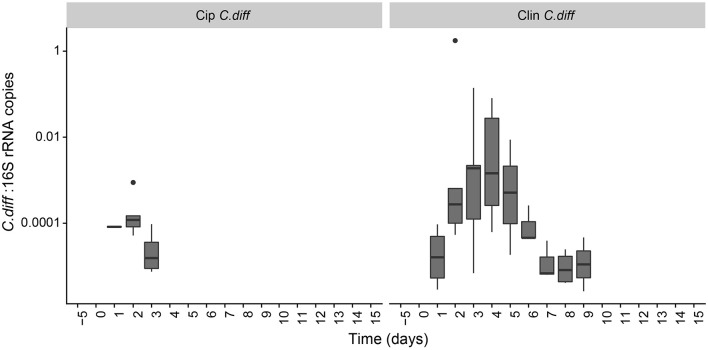
Persistence of C. difficile in the pig microbiome depended on the antibiotic pre-treatment. Ratio of C. difficile-specific 16S rRNA copies to total bacterial 16S rRNA copies in C. difficile treatments. Samples from other treatment groups had no detectable levels of C. difficile-specific 16S rRNA.